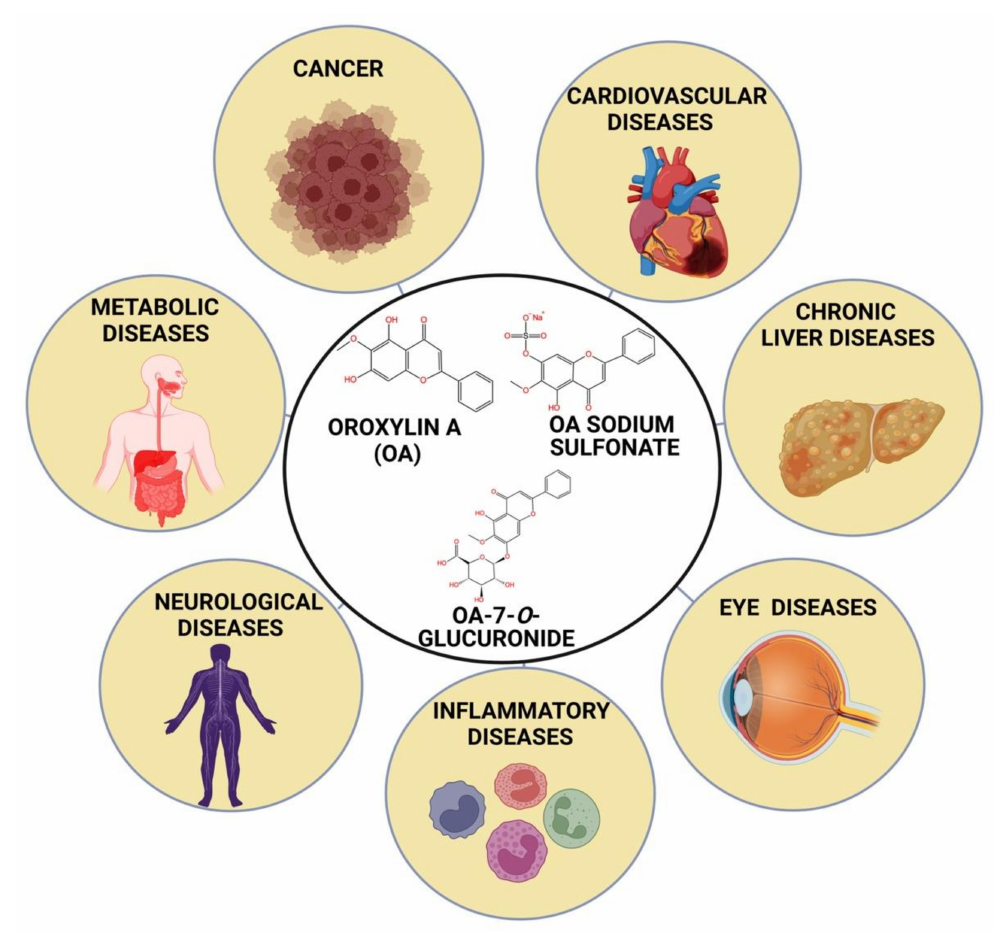
Figure 1. Role of oroxylin A and its metabolites in treating different chronic